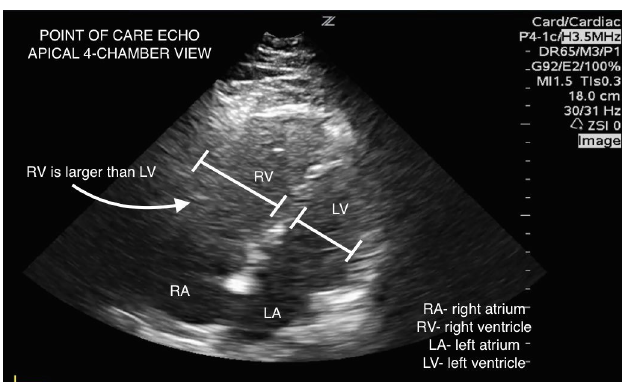
Figure 2. Point-of-care echocardiogram in apical 4-chamber view demonstrates significant right ventricle